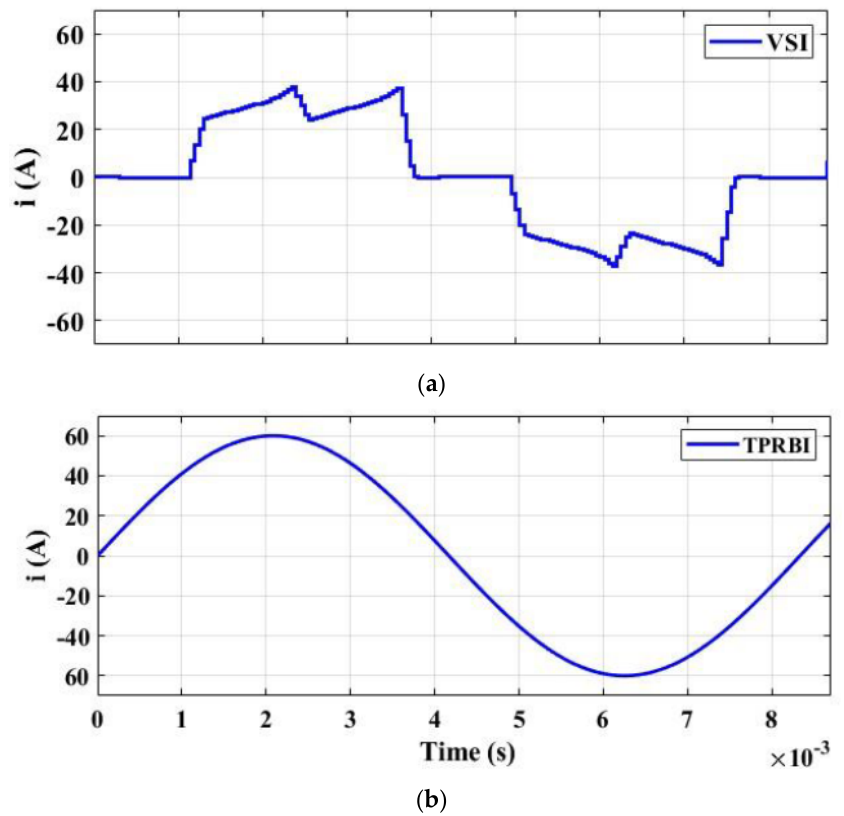
Figure 7. Simulated current waveform for ( a ) PMBLDC fed by VSI, i.e., square wave current injection,